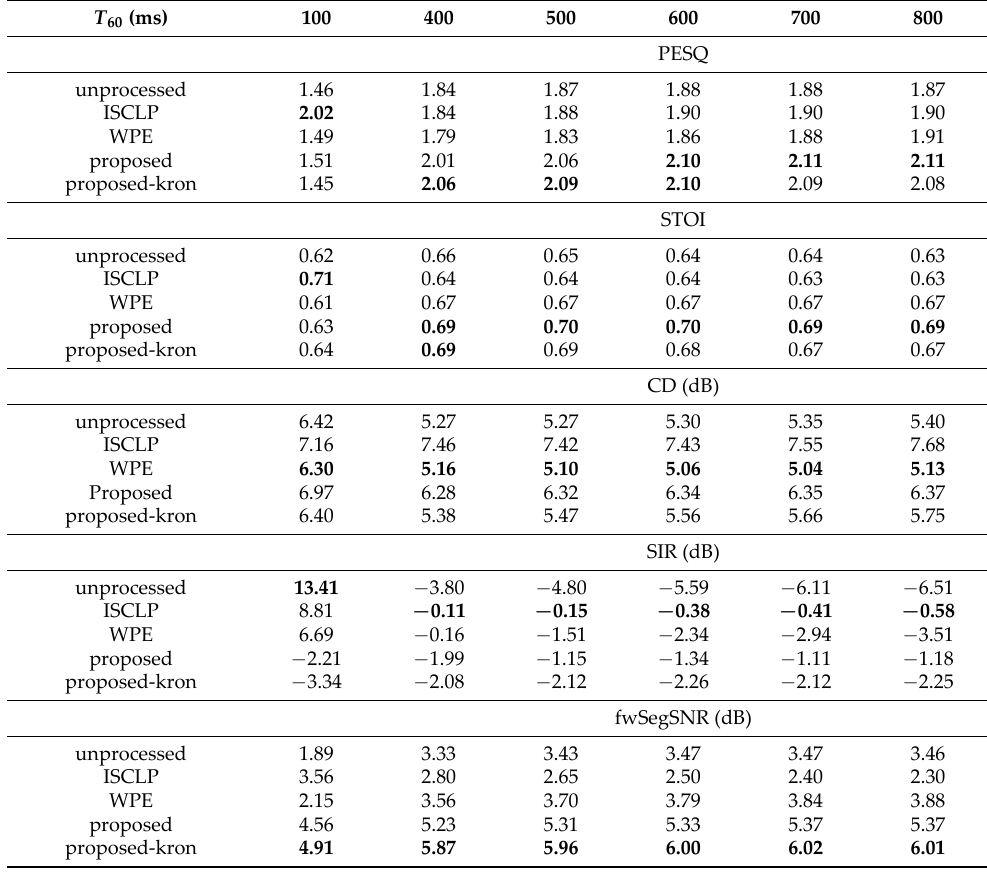
Table 2. Comparison of the test results at 0 dB for babble